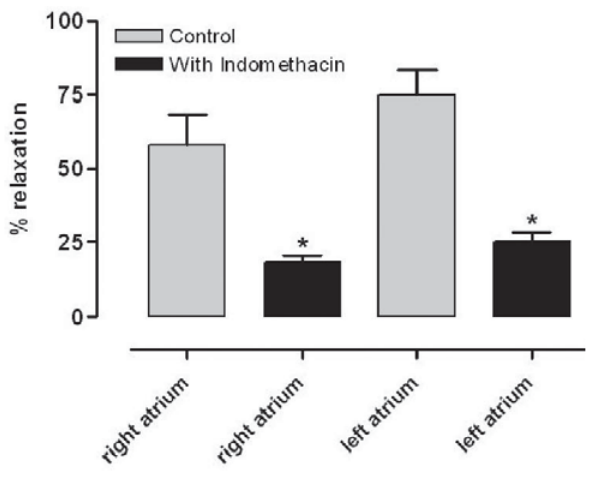
Fig. 4 - Bioassay of calcium ionophore-induced promote relaxation in the right and left atrium. The vasodilator activity of effluent from the right and left atrium was blocked blocked 67.5 + 5.2% and 68.8 + 6.9% respectively by the presence of the indomethacin (10- 5 M) in rings contracted with PGF (2x10 -6 M). Results are reported 2 α as means + SEM. * indicate significant difference between with and without indomethacin groups (P <